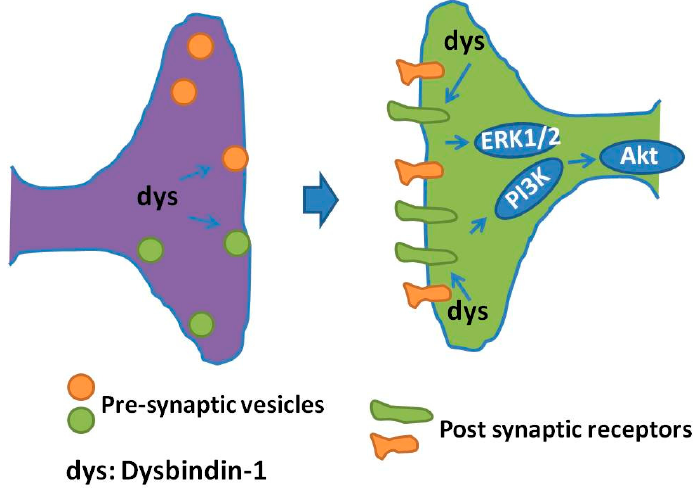
Figure 2. Regulation of dysbindin-1 on pre-synaptic vesicles and post-synaptic receptors. In the pre-synaptic terminals, dysbindin-1 regulates synaptic vesicle transport and release. In the post synaptic terminals, dysbindin-1 regulates the trafficking of neurotransmitter receptors, such as dopaminergic receptors, and affects the expression of these receptors on neuronal cell surface. Dysbindin-1 also modifies protein kinase B (Akt) and extracellular signal-regulated kinase1/2 (ERK1/2) signaling through acting on G protein receptor-induced adenylate cyclase recruitment and cAMP production.